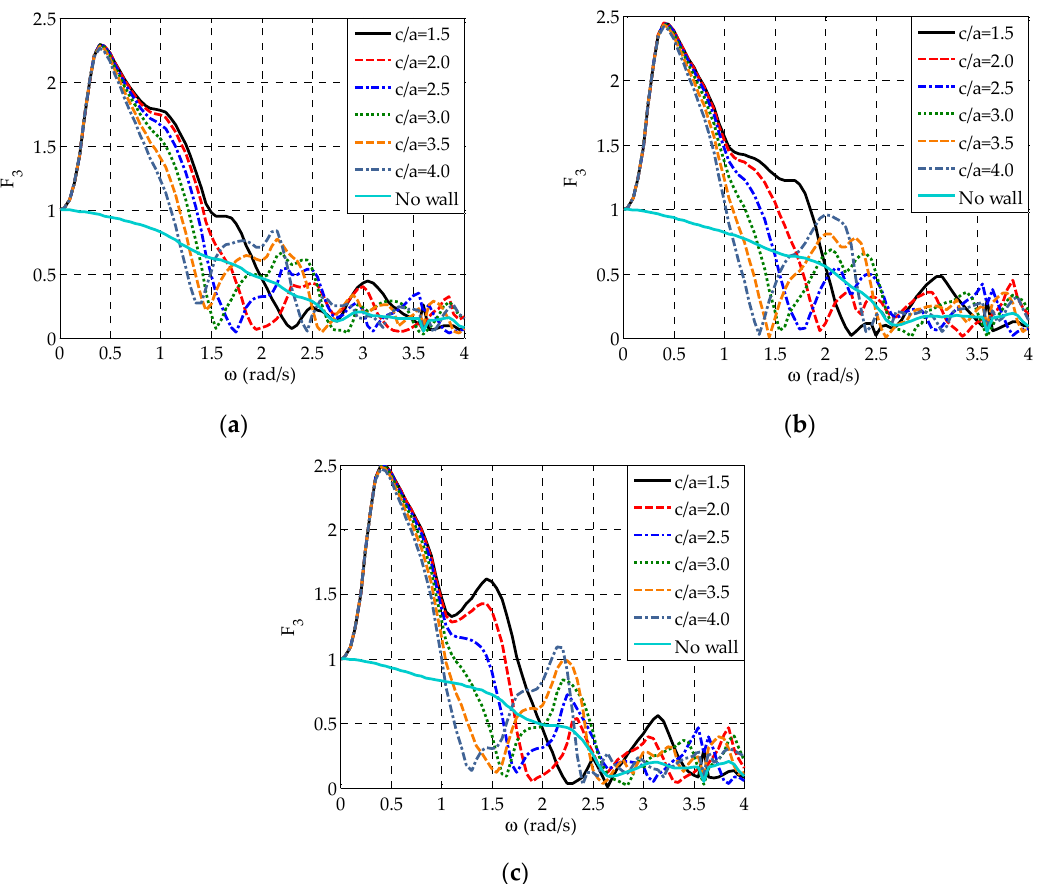
Figure 7. Effect of 𝑐/𝑎 on 𝐹 (cid:2871) applied on the semi-immersed oblate spheroidal WECs for 𝑙 (cid:3050) /𝑎 = 36 Figure 7. E ff ect of c / a on F 3 applied on the semi-immersed oblate spheroidal WECs for l w / a = 36 and and 𝑙 (cid:3029)(cid:3032)(cid:3047) /𝑎 = 4 : ( a ) WEC1 and WEC5, ( b ) WEC2 and WEC4, and ( c ) WEC3. l bet / a = 4: ( a ) WEC1 and WEC5, ( b ) WEC2 and WEC4, and ( c )